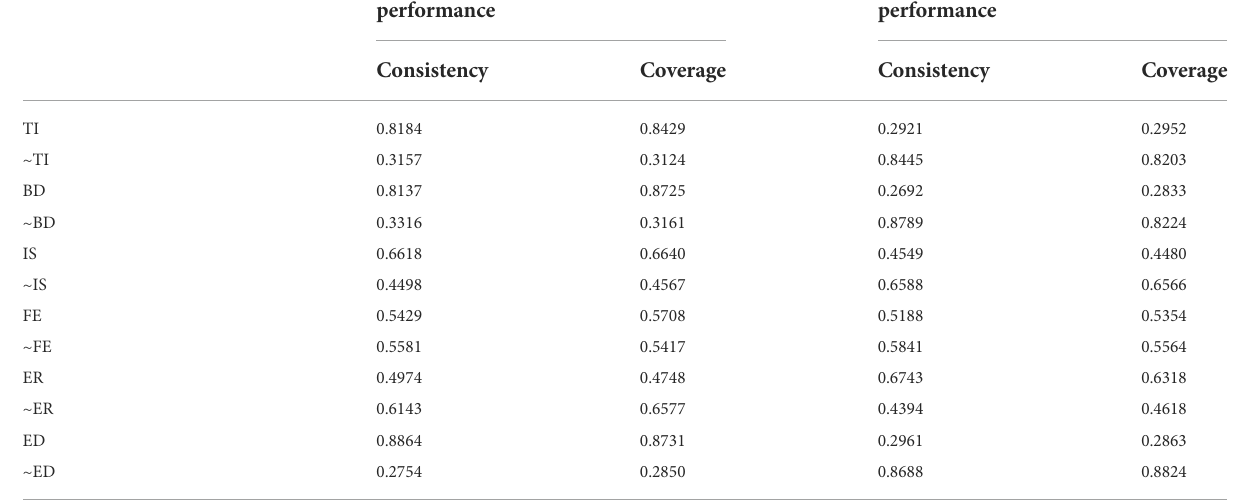
TABLE 3 Analysis of necessary